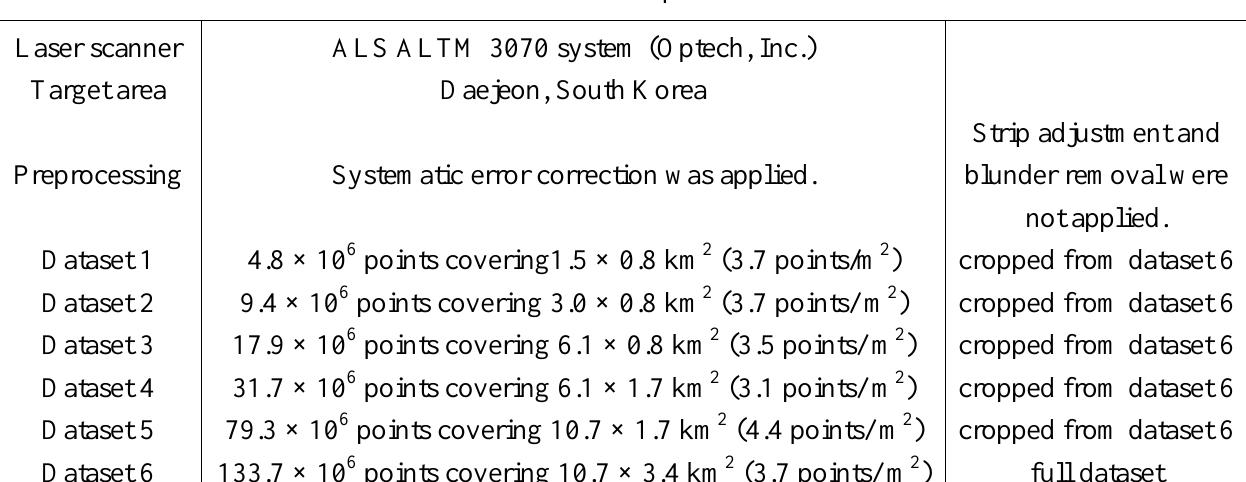
Table 1. ALS data